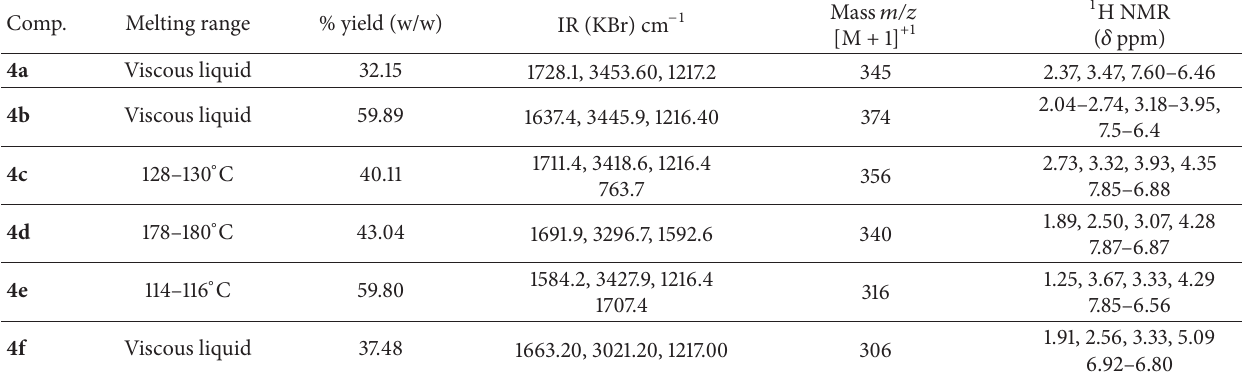
Table 1: Physical and spectral characterization of the synthesized compounds ( 4a–4f ).